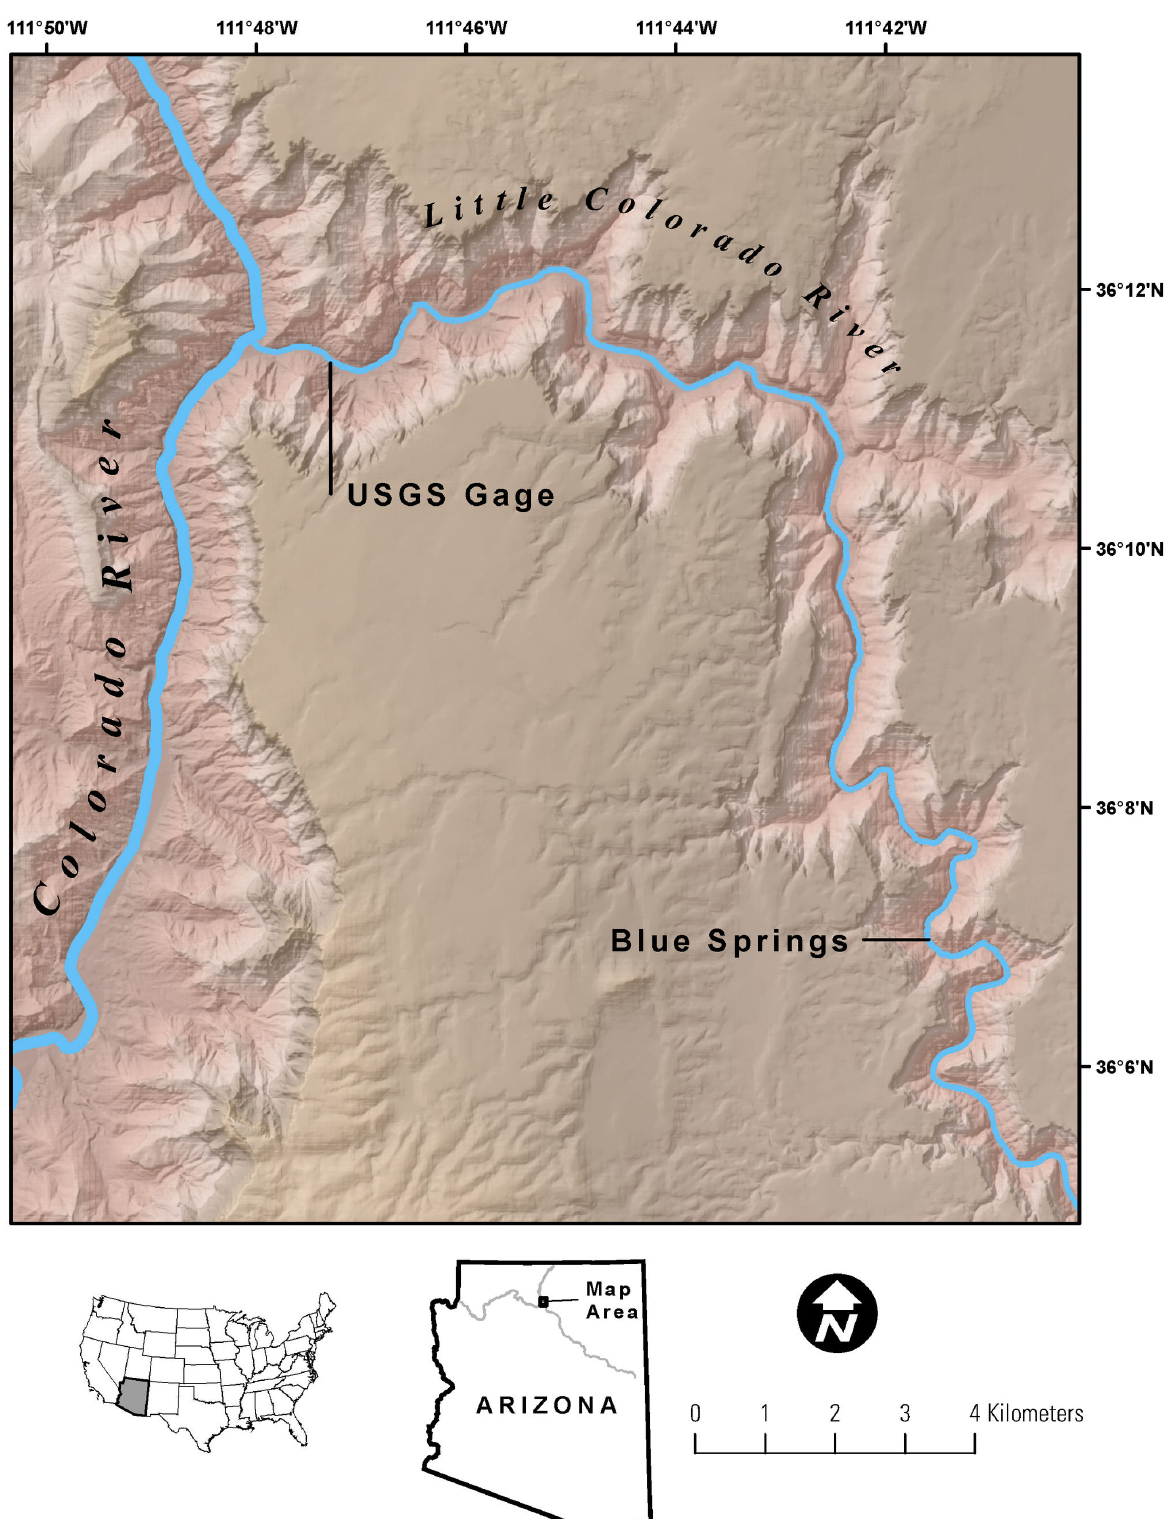
Figure 2. Map of study area, showing Little Colorado River from its confluence with the mainstem of the Colorado River up to Blue Spring, the source of elevated δ 13 C.